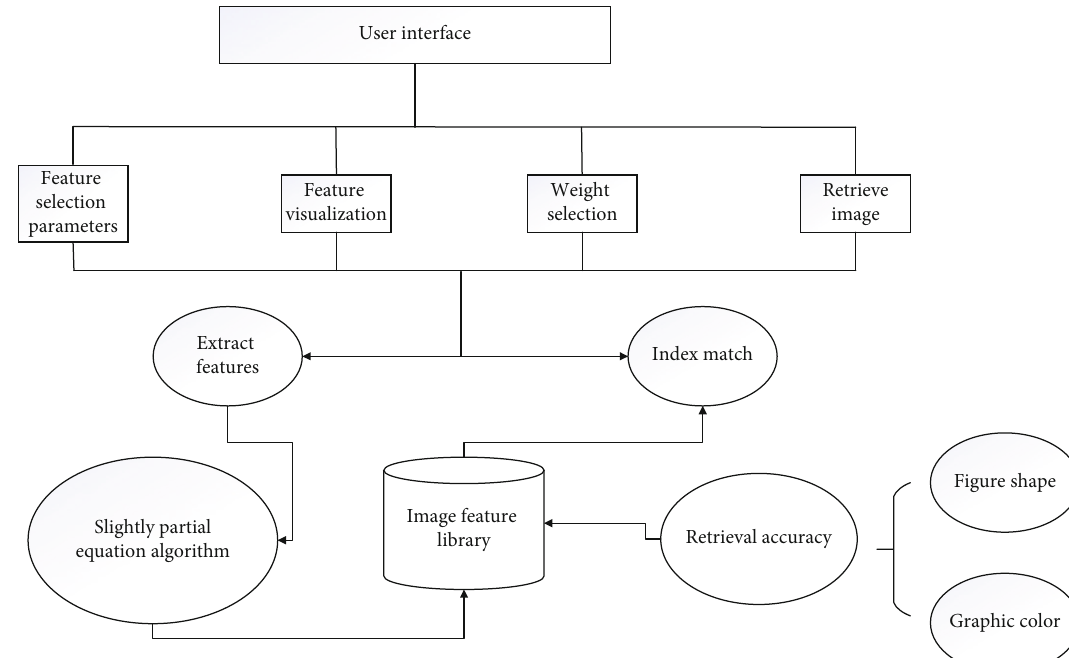
Figure 8: Image retrieval application fl ow. Table 1: Comparison of the average search rate of the two search